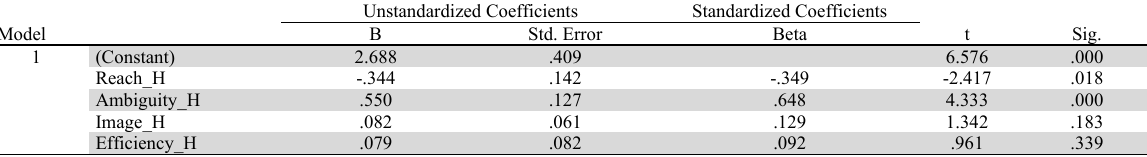
The results of testing the second hypothesis Model